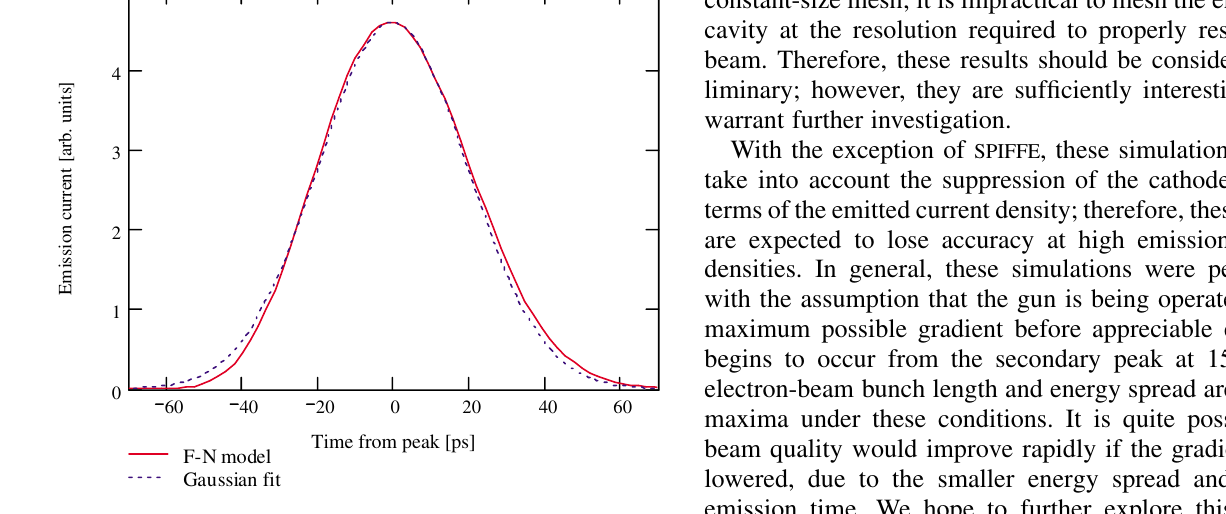
FIG. 12. (Color) Comparison of Fowler-Nordheim (F-N) calcu- lated emission curve (solid red) with a fitted Gaussian (dotted blue). The F-N curve exhibits a slight asymmetry from the field